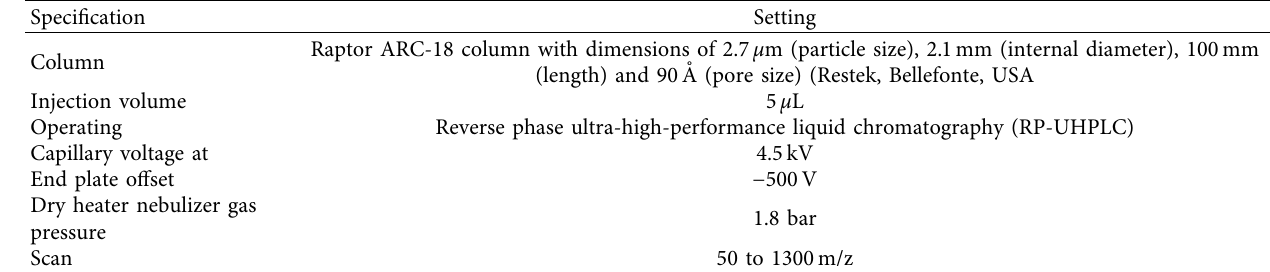
Table 2: Parameters of the LC-QTOF-MS/MS system.